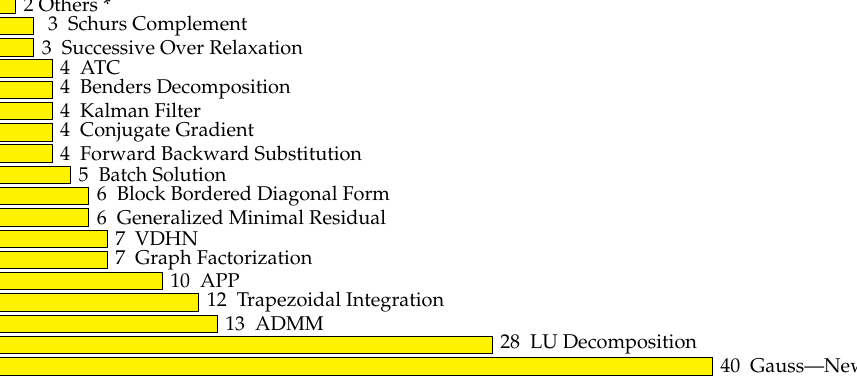
Figure 17. Frequency of decomposition methods and parallelized techniques in the literature. * (Com- pensation Network Decomposition, Propagation Delay Partitioning, PDIPM, WLS, Barrier, KKT, Waveform Relaxation, W-Matrix, Textured Decomposition, Binary Reduction, Cholesky Factorization, Lagrangian Relaxation, Monte